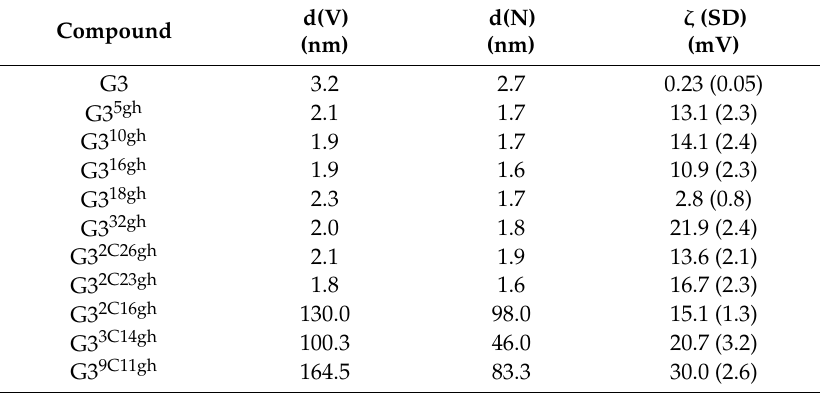
Figure A1. Size of conjugates averaged by number of molecules (d(N)) and by volume (d(V)) measured in water. Table A1. The values of number- and volume-averaged diameter (d(V) and d(N), respectively) and the zeta potential of conjugate molecules in